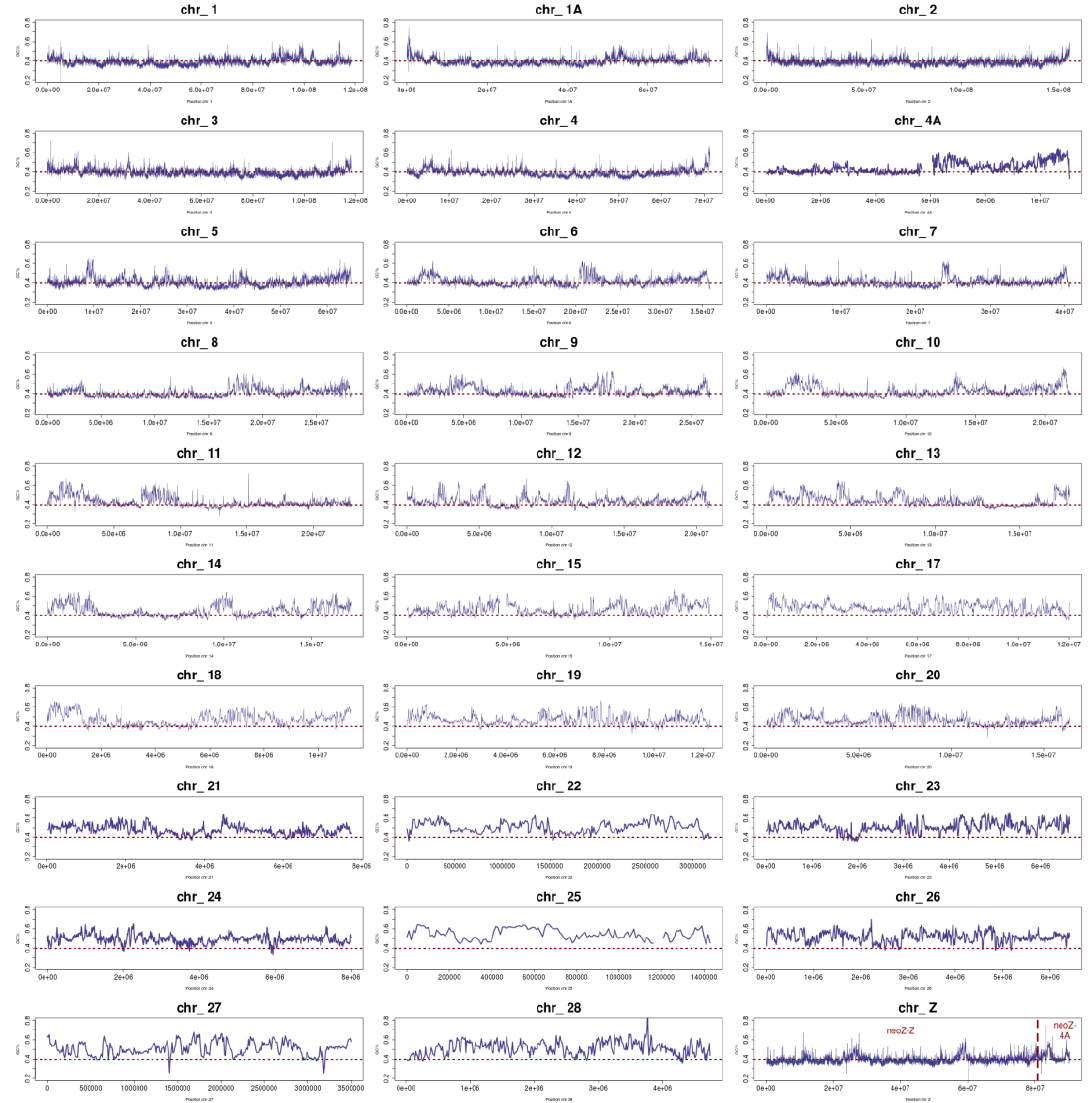
Figure S7. Variation in G+C content along 30 Z. borbonicus chromosomes. The red dotted line indicated the median GC value over non-overlapping 10kb sliding windows for scaffolds assigned to chromosomes only. As expected, strong departures from this median values are observed on